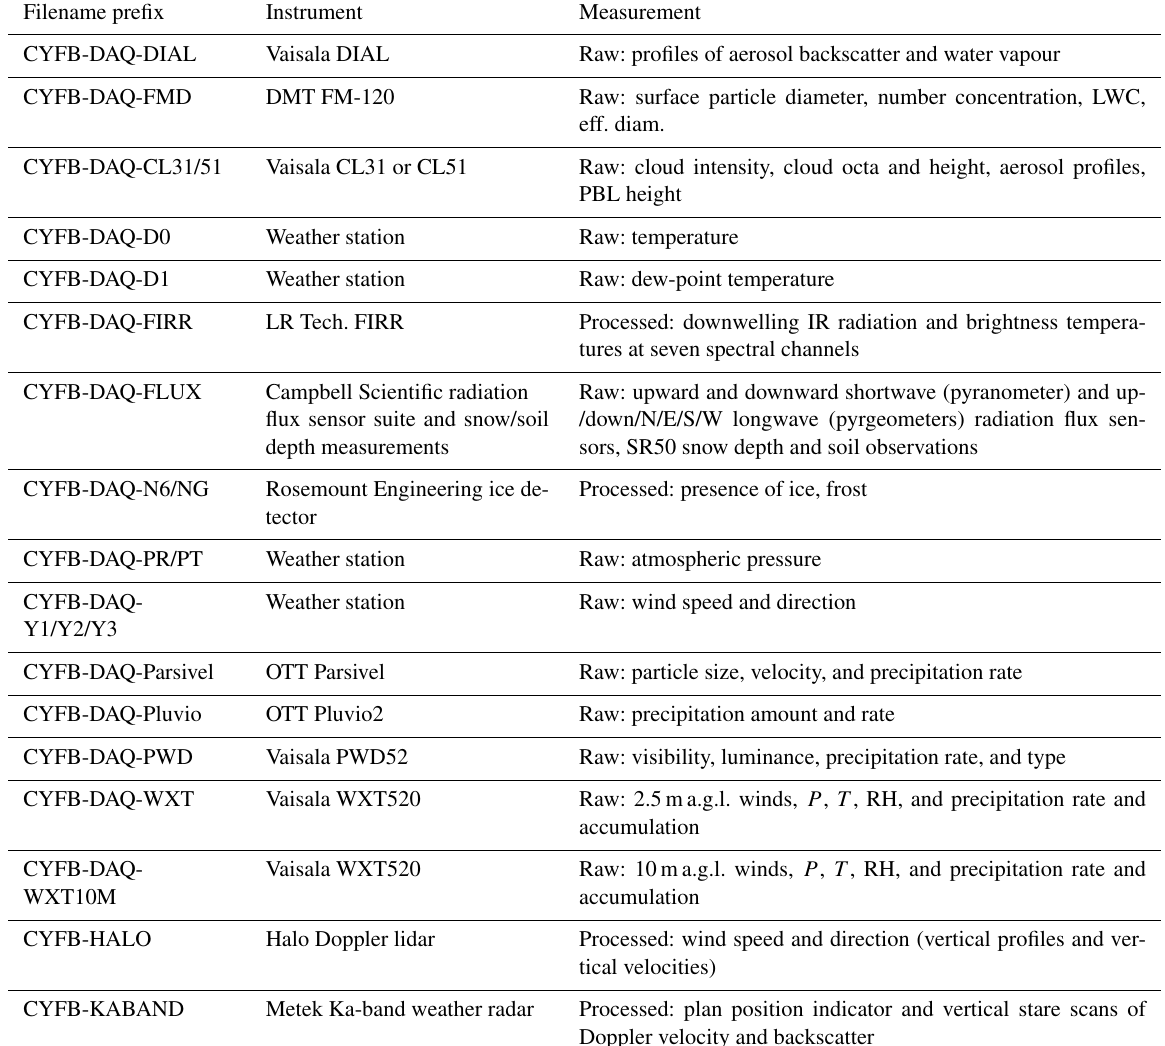
Table 3. Description of the filename structure and its contents in the Iqaluit (“CYFB”) dataset. Additional information is available via the database’s readme files. A similar file structure is used for Whitehorse, with the exception of the prefix airport code